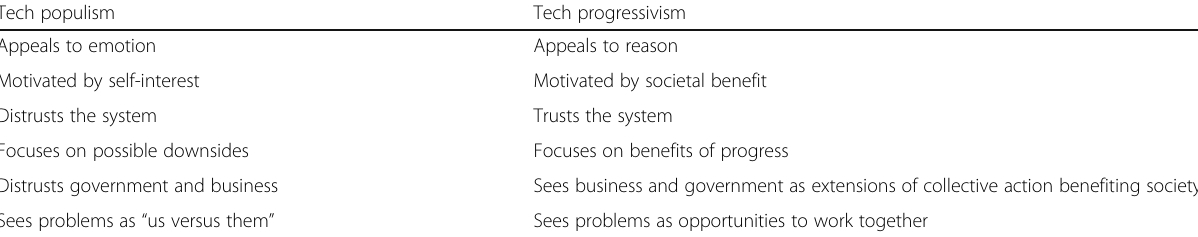
Table 1 The differences between populism and progressivism (source: ITIF, ([32], p., 2) Tech